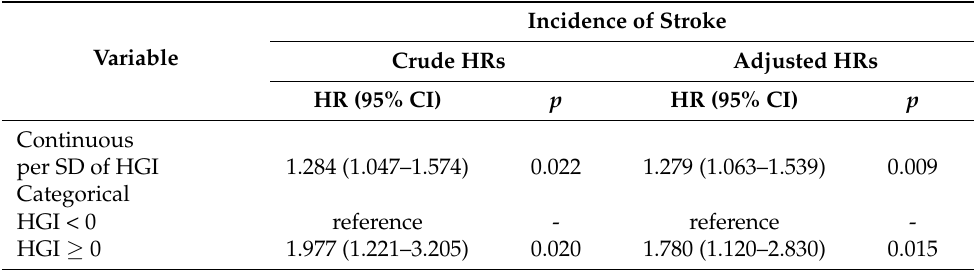
Table 2. The association of HGI and the risk of incident